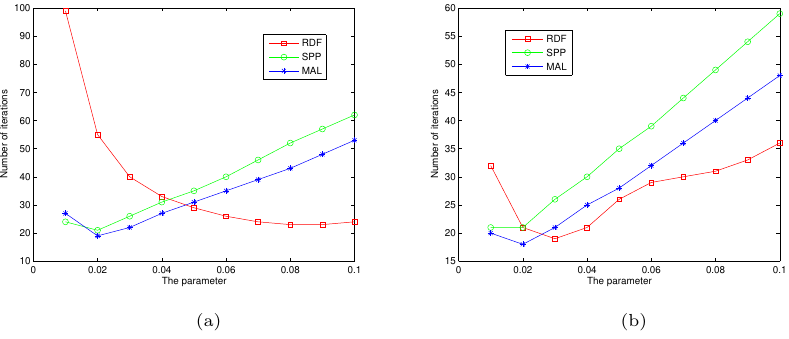
Figure 4. The sensitivity of the parameters in the RDF, SPP, and MAL preconditioners for steady Oseen problem (Q2-Q1, uniform grids, ν = 0 . 001). (a): 64 × 64. (b): 128 × 128.